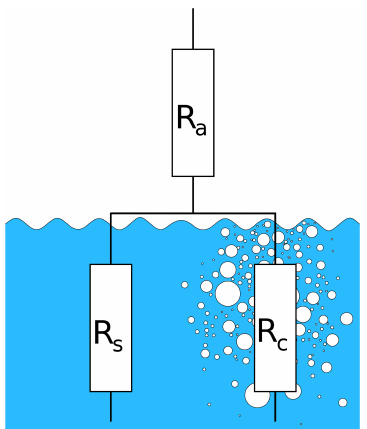
Figure 1. Transfer resistances: R a : air-side transfer resistance, R s : water-side resistance of the free water surface, R c : transfer re- sistance of the closed bubble surfaces.